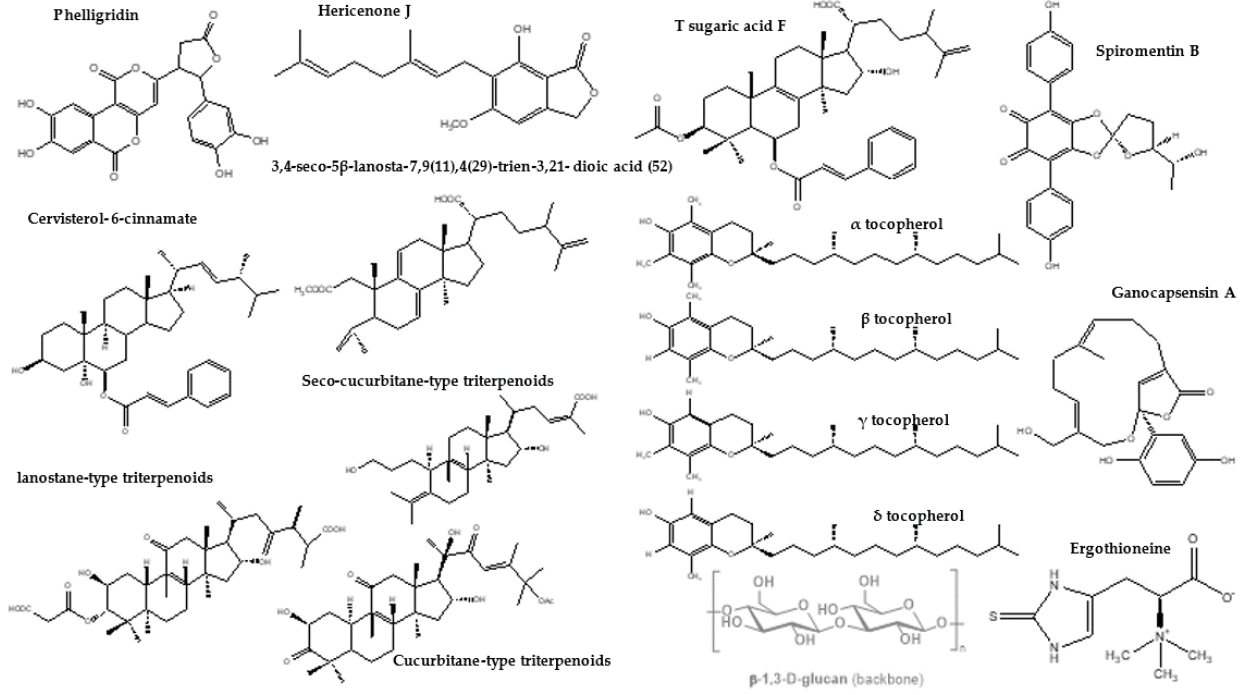
Figure 2. Chemical structures of a few representative mushroom-based nutraceuticals.